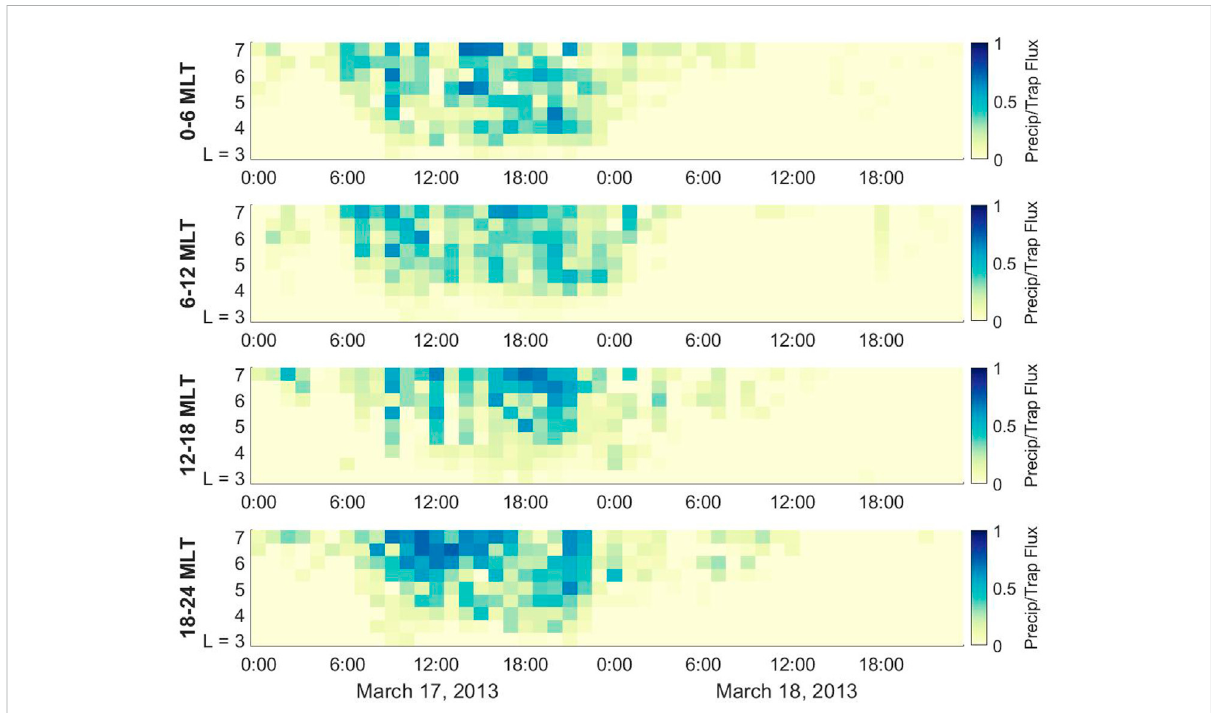
FIGURE 2 MEPED measurements of precipitating to trapped fl uxratio as a function of MLT, L-shell, and universal time on March 17-18, 2013. The data are binnedin1 htime(UT)intervalsand0.5 L-shellintervals.ThedataareobtainedfromtheNOAAPOES15,16,17,18,and19satellites,alongwithMetOp 1 and